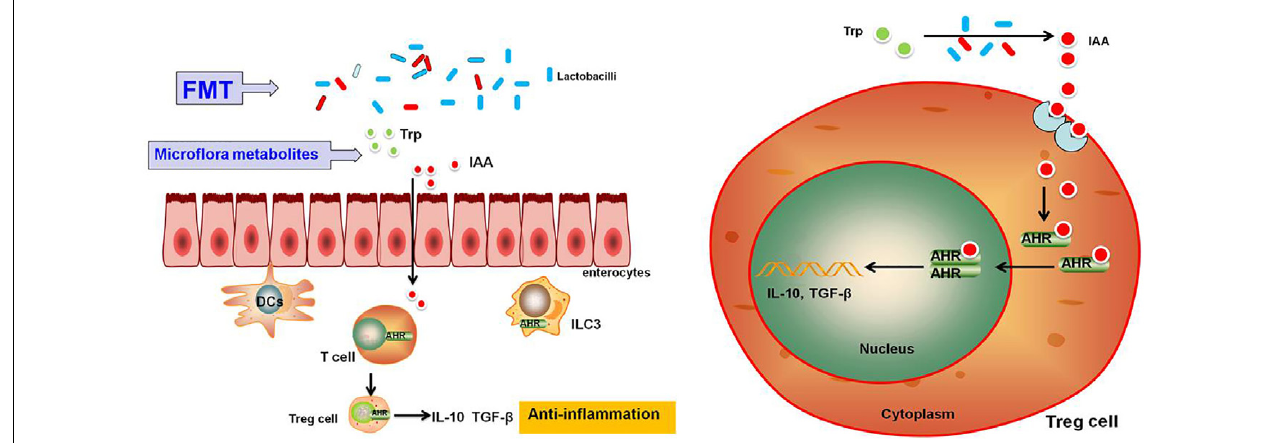
FIGURE 7 | Schematic representation of the effects of FMT on DSS-induced ulcerative colitis in mice through maintenance of the composition of intestinal microbiota and overview of the signaling pathways activated downstream of AHR. Upon treatment with FMT, homeostasis of the intestinal microbiota and metabolites will be restored, resulting in the activation of the AhR signaling pathway followed by AhR promotion of Treg cell differentiation, which is accompanied by the induction of expression of anti-inflammatory cytokines such as IL-10 and TGF- β